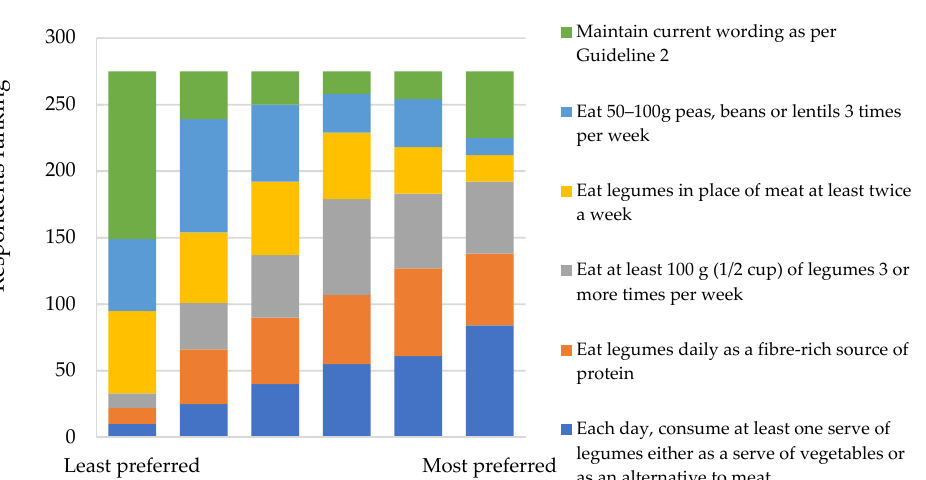
Table 4. Consumer preferences for guideline recommendations ( n = 275) * .